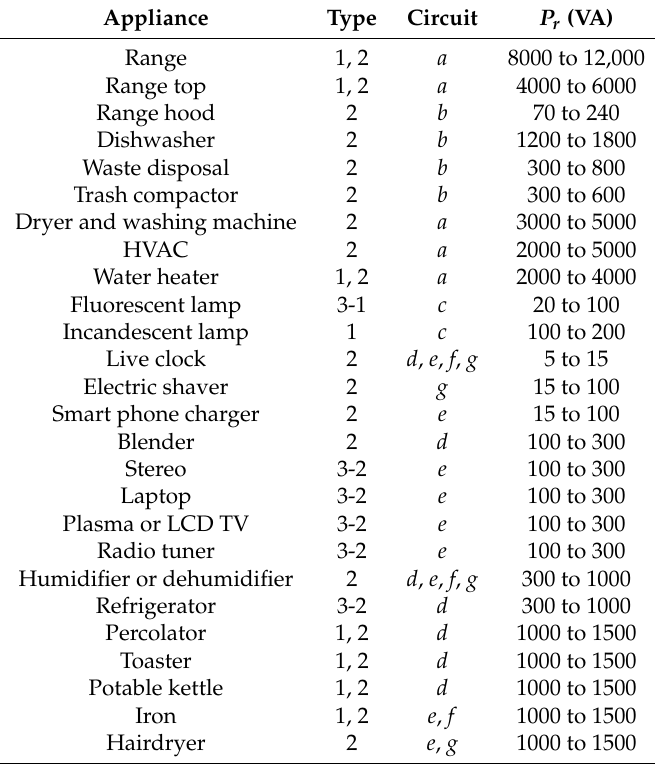
Table 1. Appliance